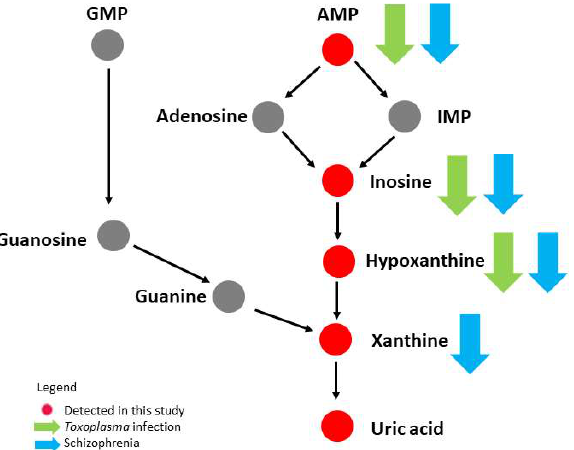
Figure 3. Alteration of the purine catabolic pathway in Toxoplasma infection and schizophrenia. The down arrow indicates a down-regulated level. AMP: adenosine monophosphate; GMP: guanosine monophosphate; IMP: inosine monophosphate.